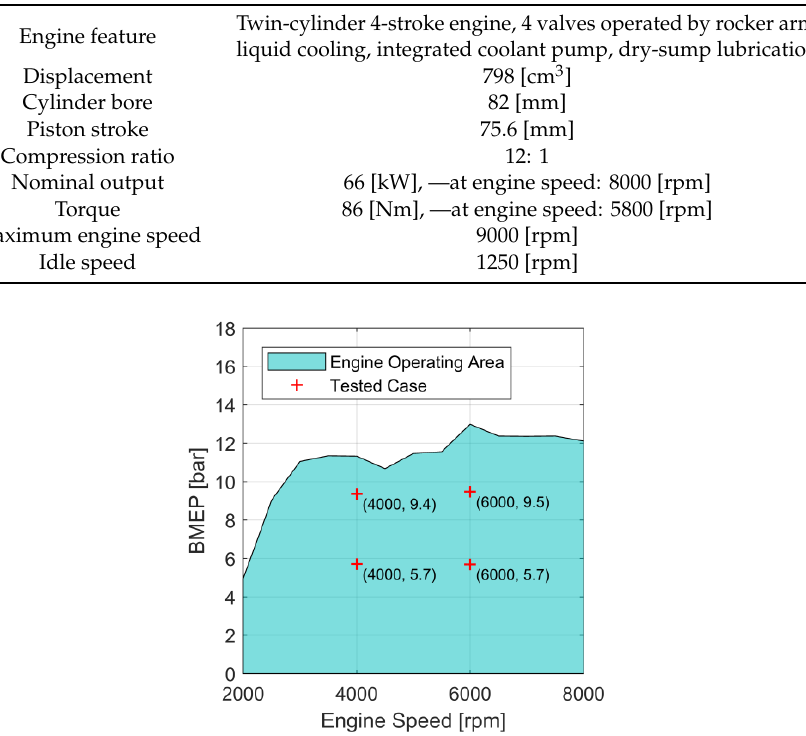
Table 1. Engine specifications.